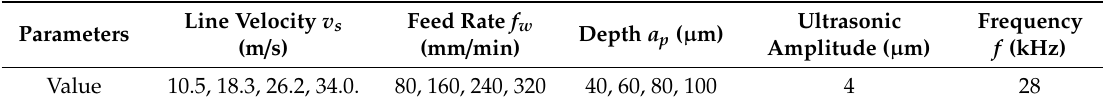
Figure 5. The schematic of ultrasonic assisted sawing experiment. ( a ) Ultrasonic vibration generator system; ( b ) Signal acquisition system.